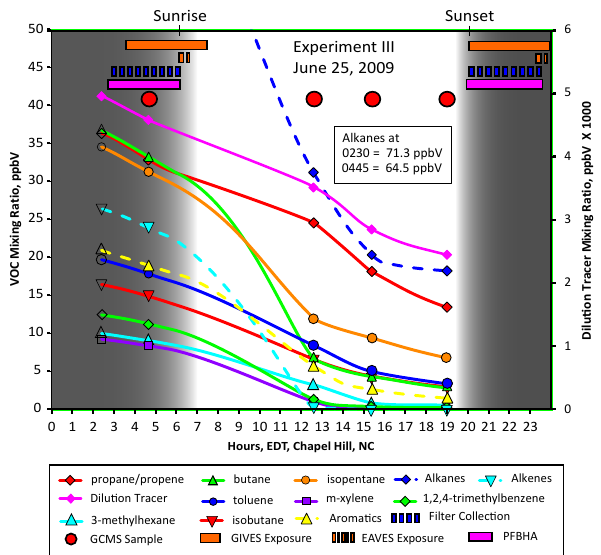
Fig. 3. Time series of explicit (solid lines) or functionally-grouped (dashed lines) primary (injected) VOC mixing ratios during exper- iment III (JN2509), performed with SynUrb54 and NO x injected in the dark at 02:30EDT. Explicitly represented species are not in- cluded in their functional group mixing ratio values. Colored bars and large red dots are as in Fig. 2. See Table 4 for mixing ratio values at specific time points.